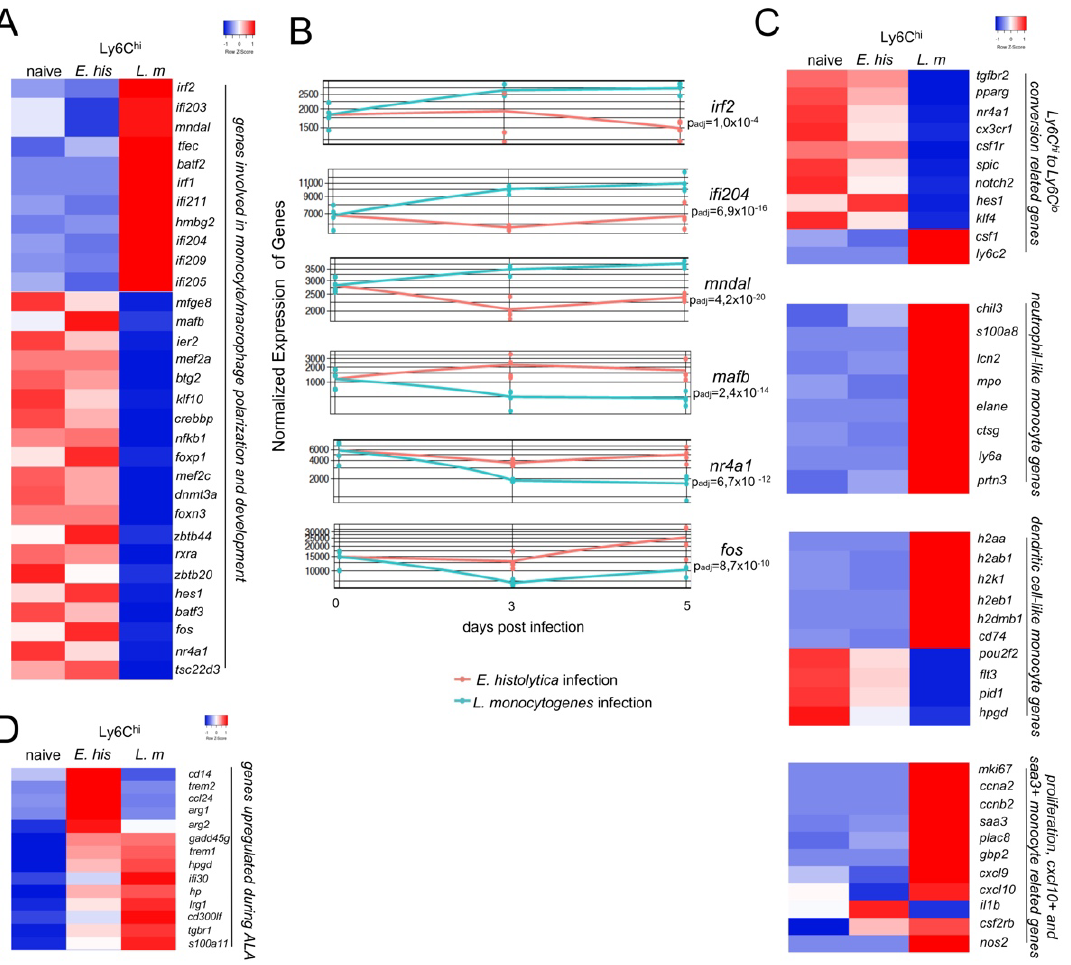
Figure 3. Early M2 polarization and a less activated mRNA expression profile in Ly6C hi monocytes from E. histolytica -infected compared to L. monocytogenes -infected mice. ( A ) Heat map showing selected regulated genes (p adj < 0.05; foldchange > 2) involved in monocyte/macrophage polarization and activation of Ly6C hi monocytes derived from the livers of E. histolytica ( E. his )- and L. monocytogenes (L. m)-infected. ( B ) Time-course analysis of mRNA encoding M2 transcription factors and interferon-regulated/activated factors. ( C ) Heatmap showing classification of Ly6C hi monocytes derived from the livers of both infection models according to expression of genes involved in conversion from Ly6C hi to Ly6C lo , neutrophil-like, dendritic cell-like, or Cxcl10 + and Saa3 + -like monocytes. ( D ) Heat map of selected genes upregulated during ALA. All heatmaps were designed using the online tool “heatmapper” [34].